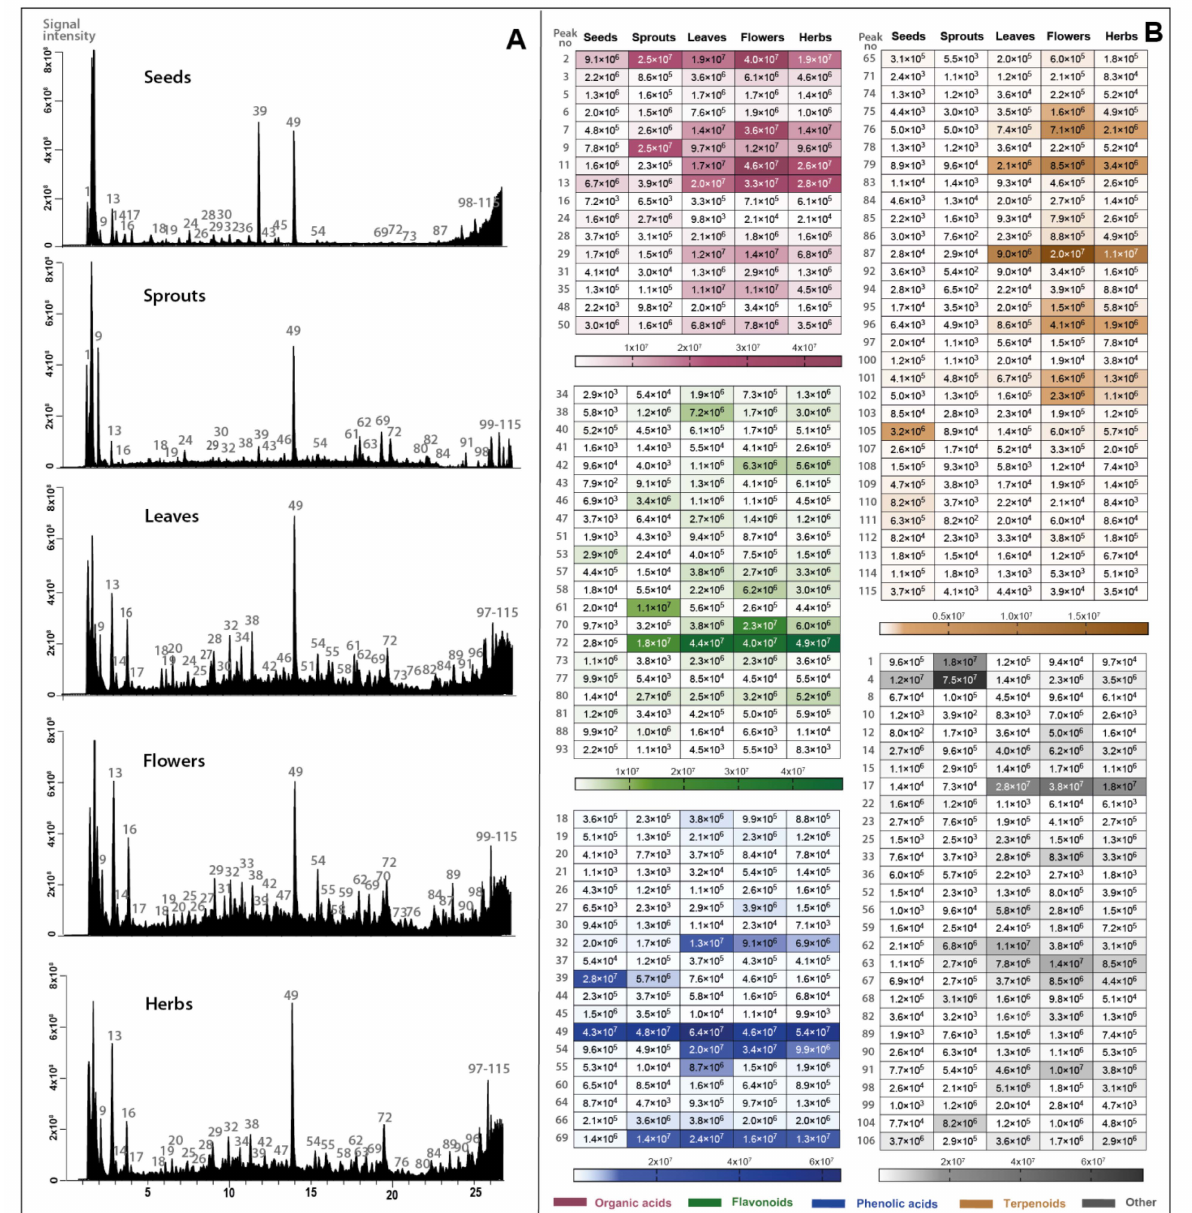
Figure 1. Total ion chromatograms (registered in negative-ion mode) ( A ) set with heat map repre- senting the mean peak area value of the identified compounds ( B ) detected in extracts from different parts of S. hispanica . For identity of peaks, see Table